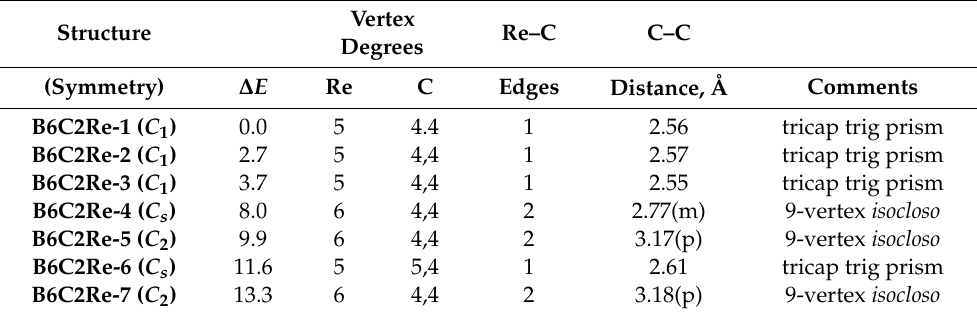
Figure 4. The seven optimized lowest energy 9-vertex C 2 B 6 H 8 Re(CO) 2 (NO) structures. Table 2. The seven optimized 9-vertex C 2 B 6 H 8 Re(CO) 2 (NO) structures within 17 kcal / mol of the lowest energy structure.